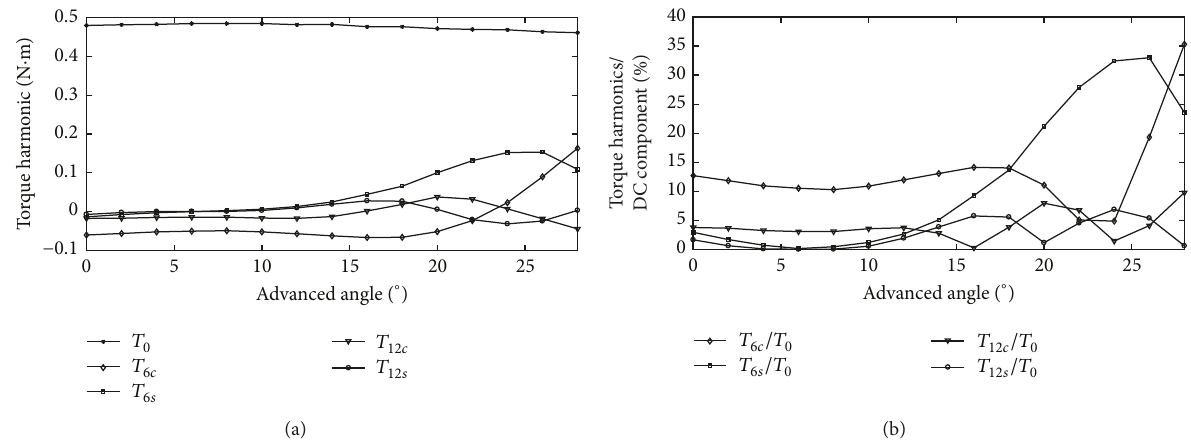
Figure 6: (a) Torque harmonic amplitude diagram. (b) The ratio of torque harmonics to DC component.